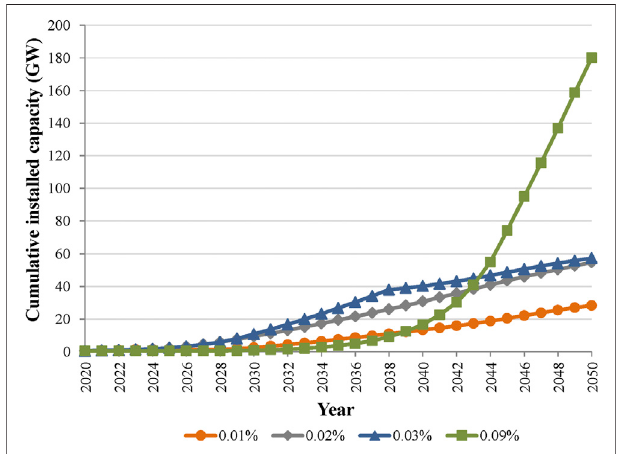
FIGURE 8 | Cumulative installed capacity of CSP under different learning